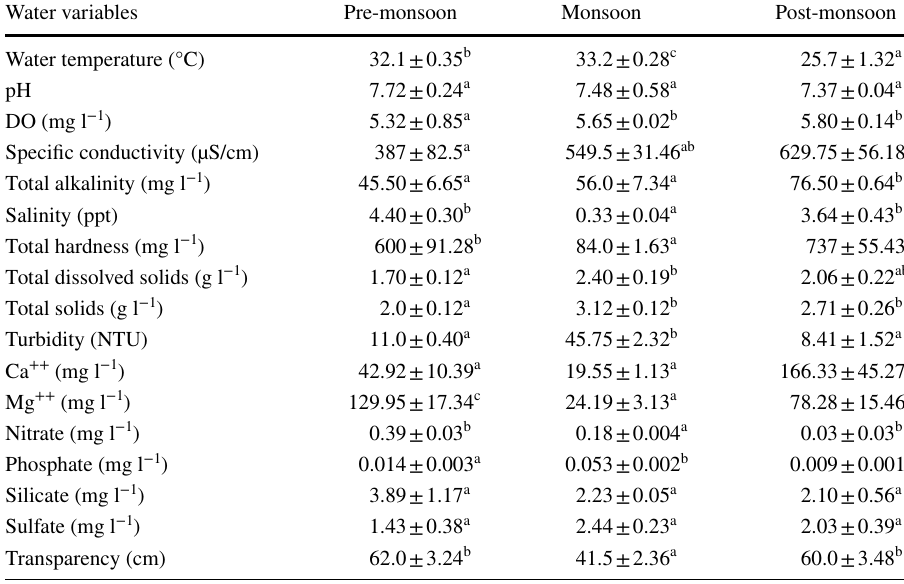
The table included the mean differences of (post hoc Tukey test) ‘physicochemical’ parameters. Means of the three columns of a particular parameter followed by the same letter ( s ) are not significantly different from each other ( p